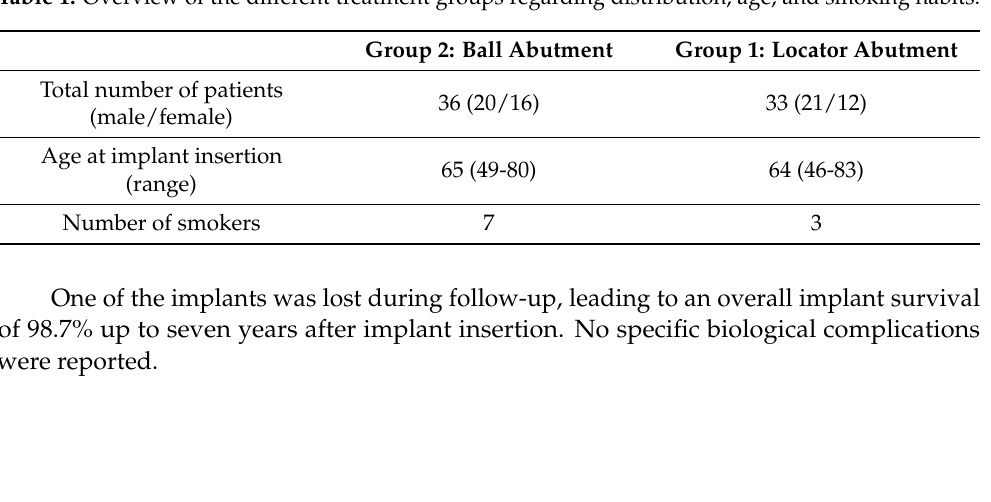
Figure 2. Decision tree used to select the cases to be assessed. Table 1. Overview of the different treatment groups regarding distribution, age, and smoking habits.